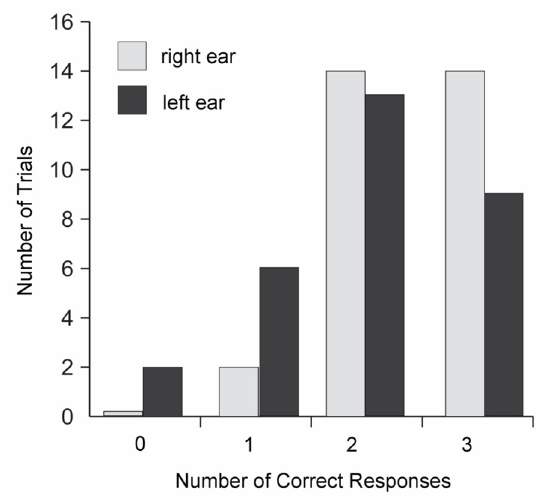
Figure 2. Dichotic test in the examined patient.